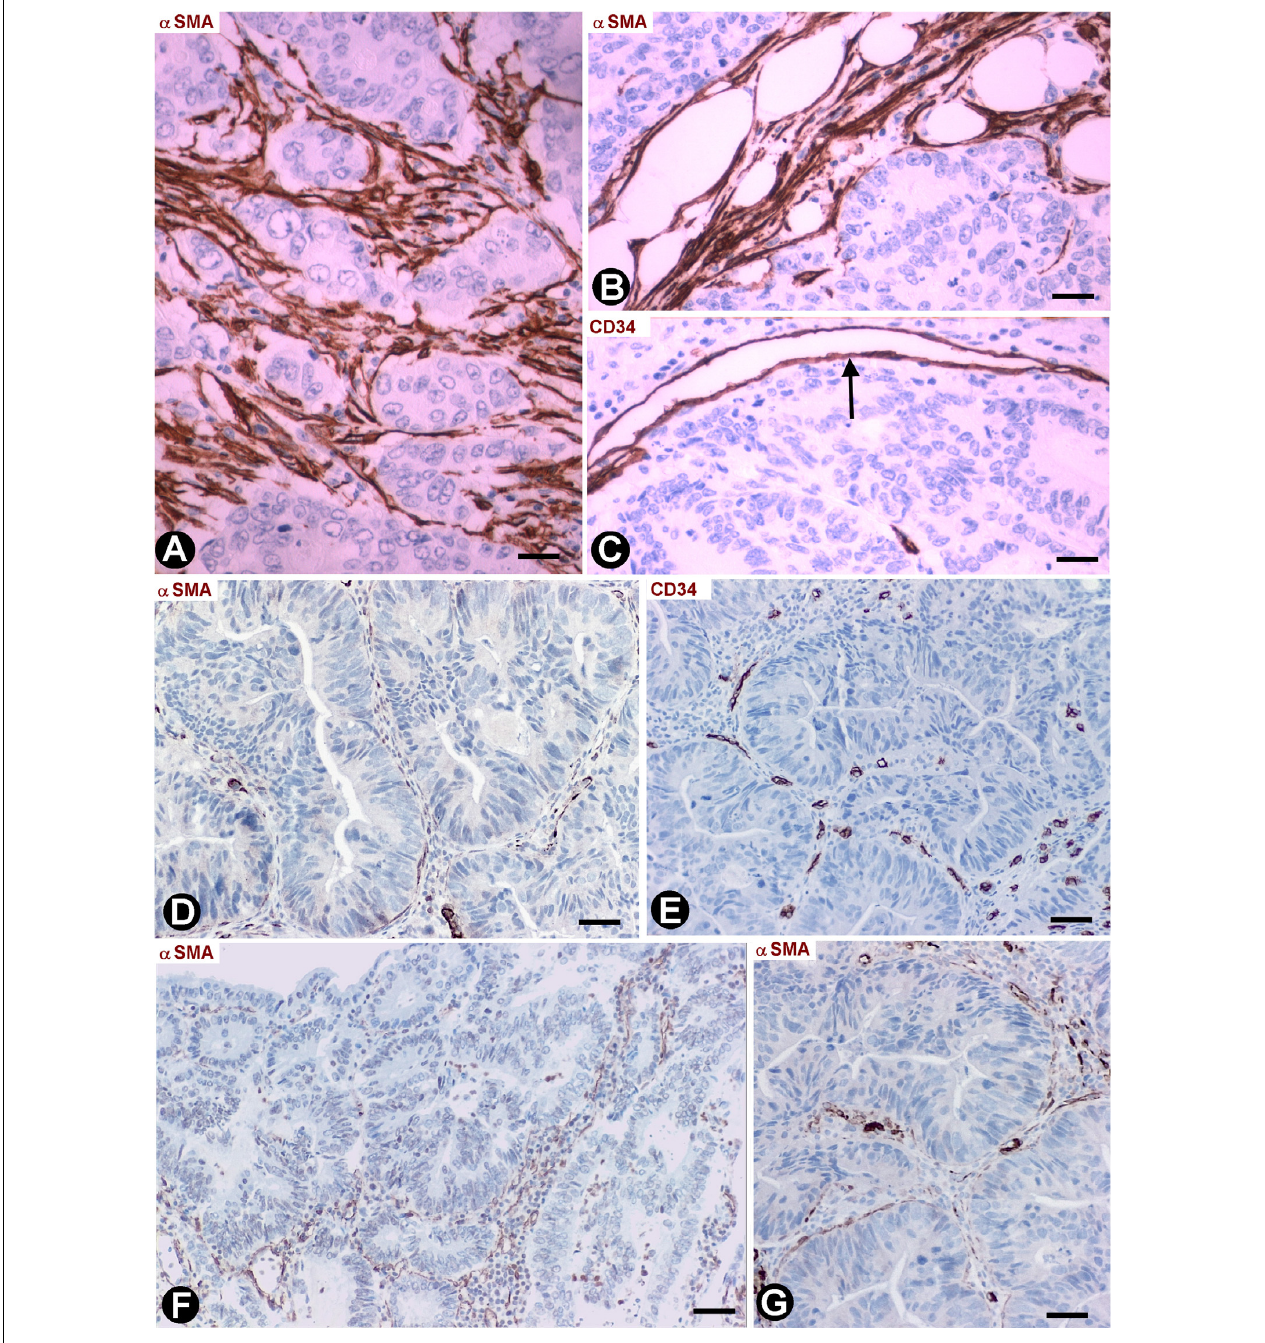
FIGURE 6 | Stromal cells in infiltrative carcinomas of colon. (A,B,D,F,G) Sections stained with anti- α SMA. (C,E) Sections stained with anti-CD34. (A,B) α SMA+ stromal cells (brown) are observed around neoplastic glands in the submucosa (A) and serosa (B) . (C) Absence of CD34+SCs/TCs around neoplastic glands in the submucosa. Note that the endothelial cells are the only cells expressing CD34 (arrow). (D–G) Neoplastic glands in the mucosa. The stromal cell reaction is scarce and irregular with few α SMA+ cells (brown) (D,F,G) . CD34+SCs/TCs s are absent (E) . Bar: (A) 20 µ m; (B–G) 40 µ